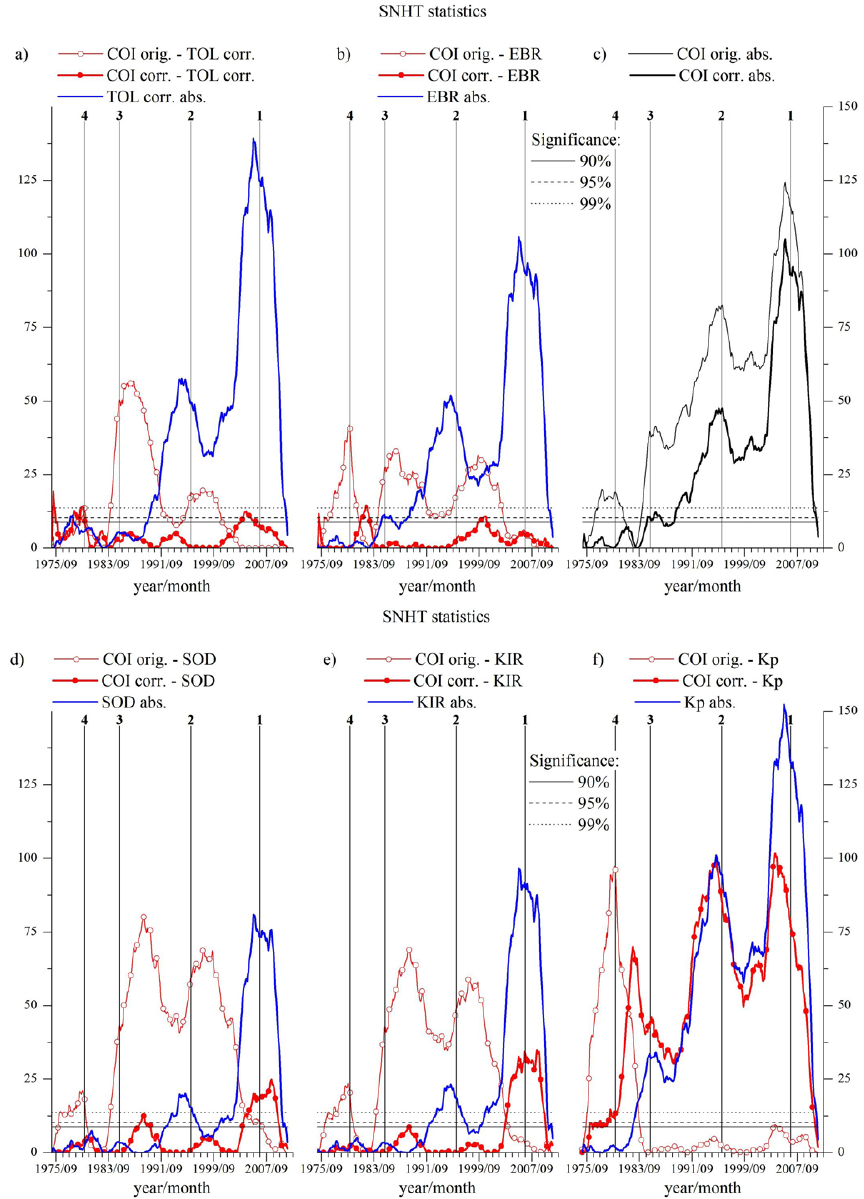
Fig. 4. Homogeneity test statistics of COI Ki in relative (compared to TOL Ki (a) , EBR Ki (b) , SOD Ki (d) , KIR Ki (e) and Kp (f) ) and absolute (c) modes for the period from 1975 to 2010. Absolute test statistics are shown by lines without dots. Thin lines – before correction, thick lines – after correction. Vertical lines mark periods of possible homogeneity breaks for COI data (see Table 1). Significance levels are marked by horizontal